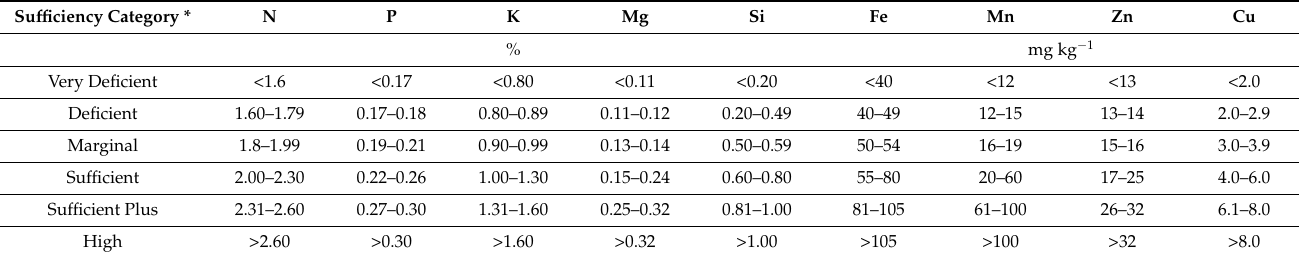
Table A1. Sugarcane leaf nutrient sufficiency ranges for defining nutrient management categories (McCray and Mylavarapu, 2010). Sufficiency Category